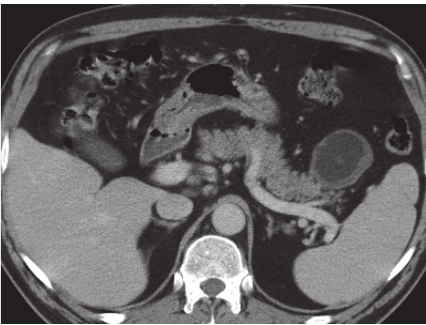
Figure 1: Computed tomography (CT) of the abdomen showing a complex solid cystic mass in the distal pancreatic tail.